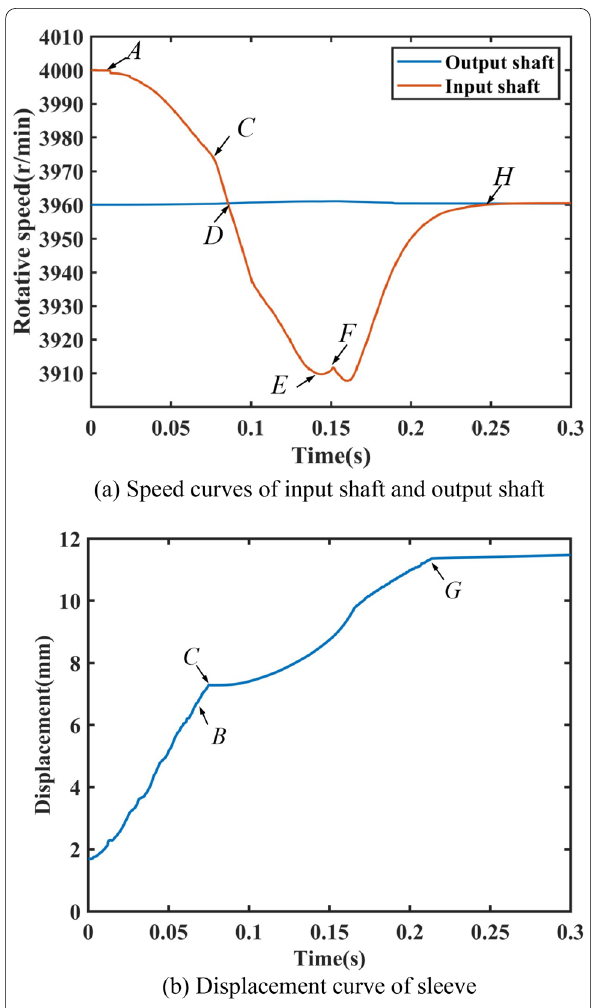
Figure 19 Transmission movement state during shifting